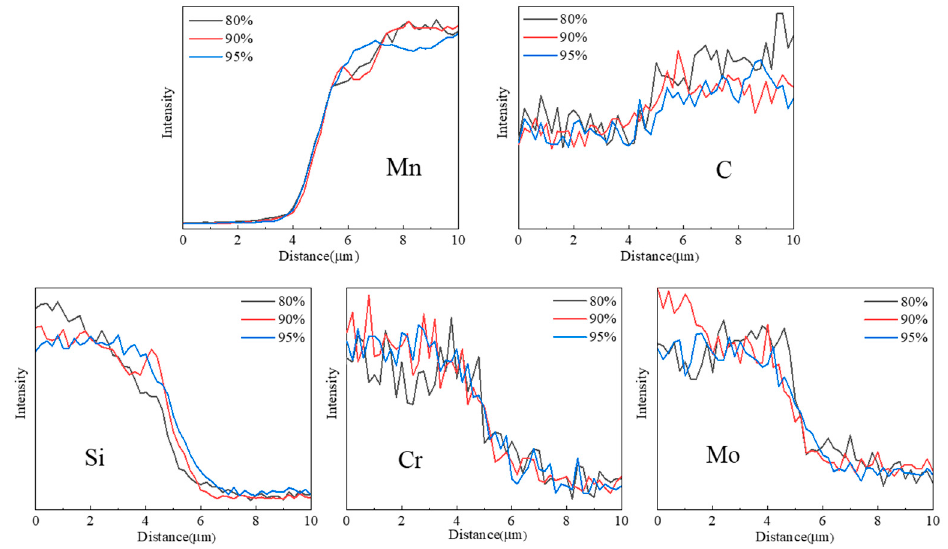
Figure 6. EPMA line scan of the element distributions of multilayer TWIP/40Si2CrMo steels with different hot rolling reductions.